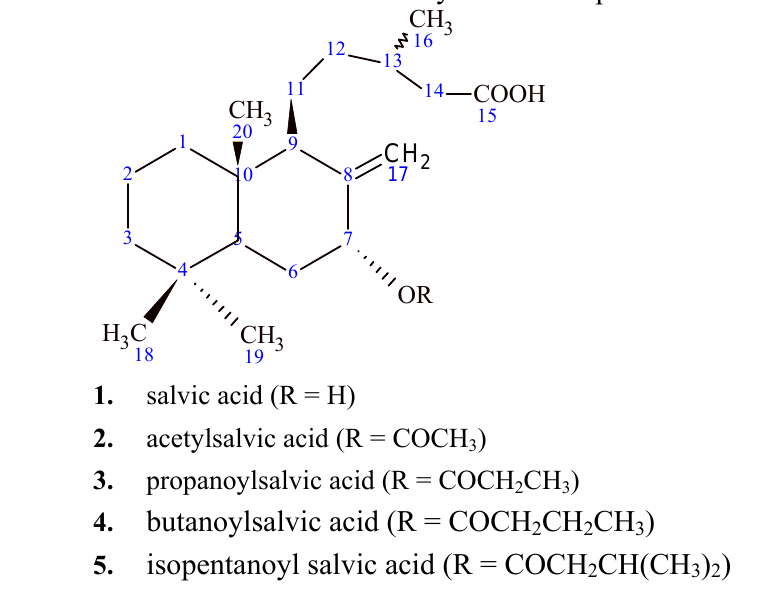
Figure 1. Structure of natural and hemisynthetic diterpenoids.